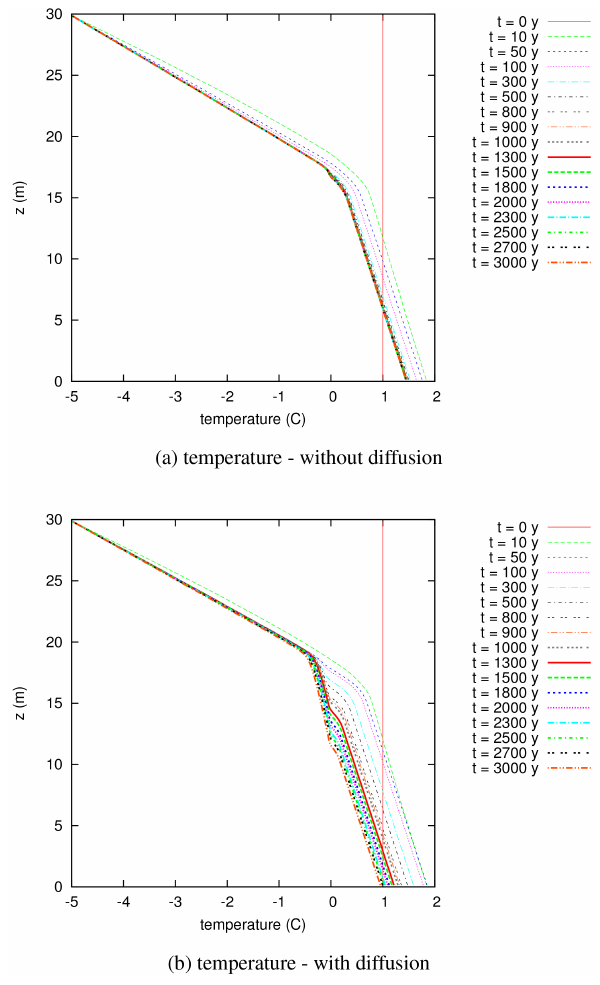
Figure 5. Comparison of temperature profiles for the cases with and without vapor diffusion for the one-dimensional vertical do- main. The parameters used are permeability = 1.3 × 10 − 13 m 2 , thermal conductivity (dry) = 0.25Wm − 1 K − 1 , thermal conduc- tivity (wet) = 1.3Wm − 1 K − 1 , α u = 0.45, α f = 0.95, thermal con- ductivity (frozen) = 2.36Wm − 1 K − 1 , porosity = 0.45, soil den- sity = 2700kgm − 3 , specific heat = 837Jkg − 1 K − 1 , λ = 0.721 and α = 2.8 × 10 − 4 Pa − 1 . Tortuosity is set to 1 for the case with diffu- sion turned